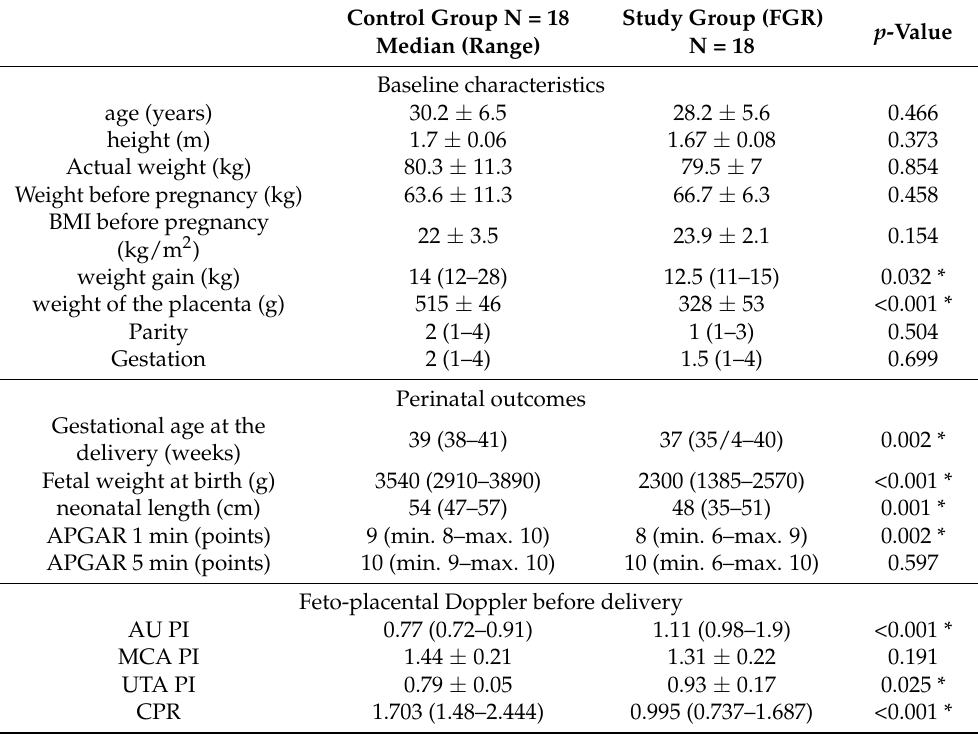
Table 1. Clinical characteristics and anthropometric measurements of mothers and newborns.